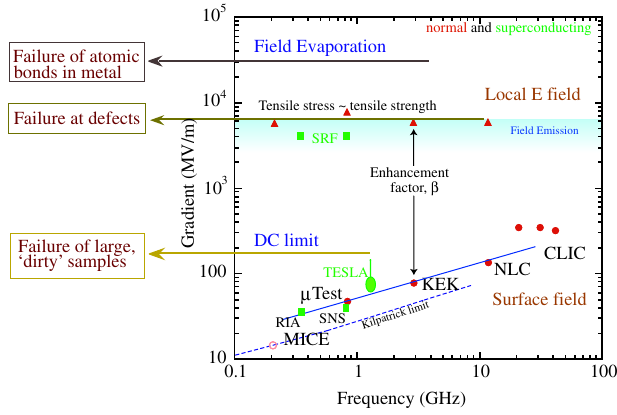
FIG. 1. (Color) Local and average surface electric fields as a function of frequency for superconducting and normal rf accel- erating cavities. Local fields of (cid:2) 7 GV =m are associated with breakdown in many structures. Superconducting rf (SCRF) data is described in Sec. IV. The copper data is from Refs. [1,31,32,35] and the SCRF data is from Refs. [6,45,46]. The indicted line for field evaporation is an approximate upper